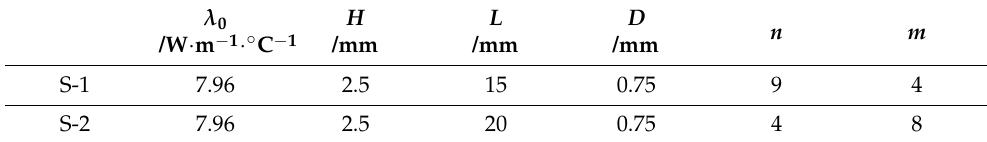
Table 4. Parameters of the single